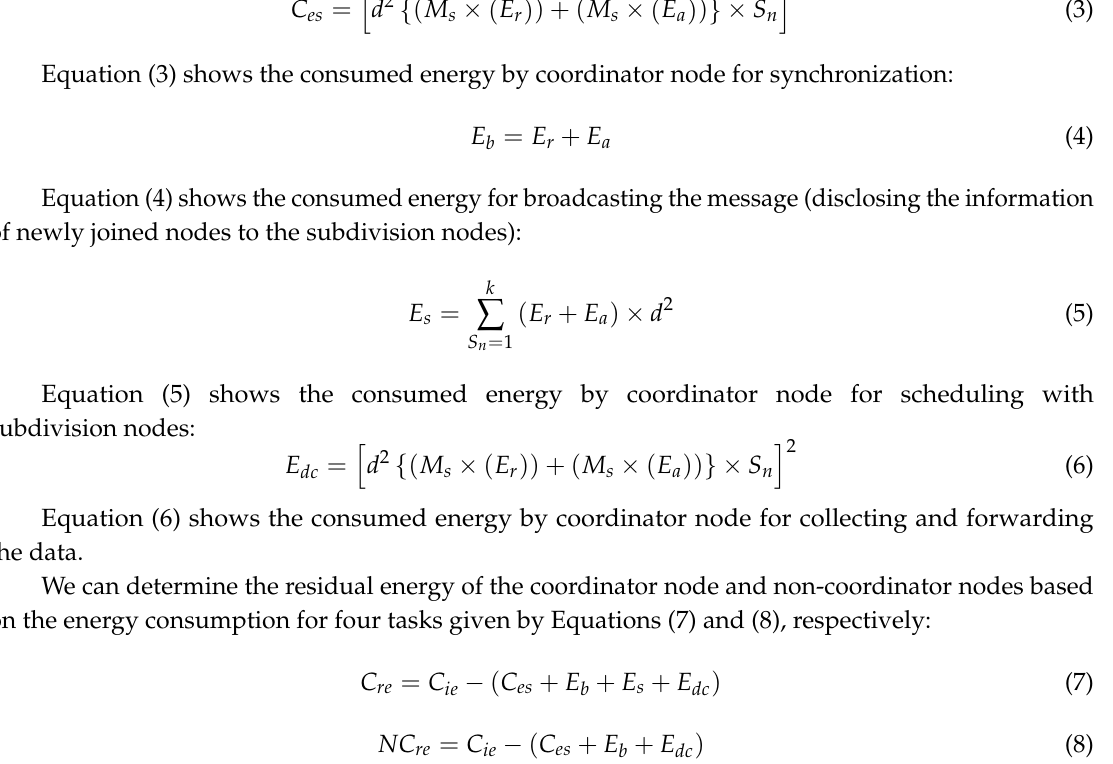
Table 2. Notations used and their description.